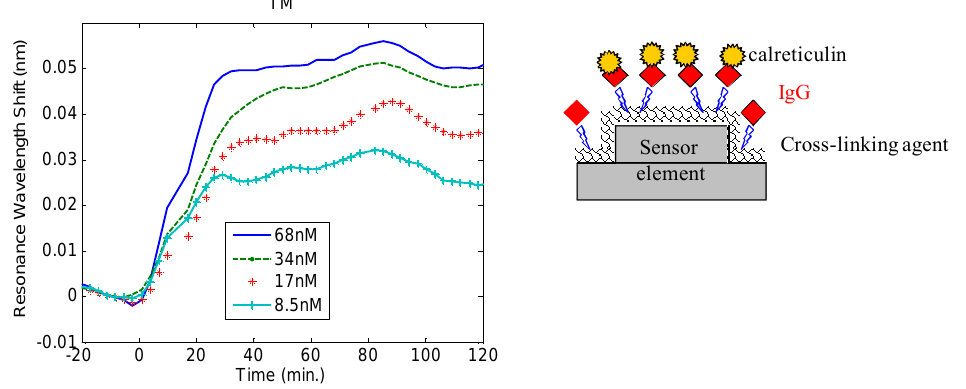
Figure 7. Dual polarization resonance response for calreticulin binding to the activated sensor element. These results are gathered after a post-PBS/Tween wash, indicating bound calreticulin remaining on the sensor surface. A PBS blank is used as a reference and subtracted from the data. Results are repeated in duplicate and averaged. Error bars shown indicate estimated uncertainty in each